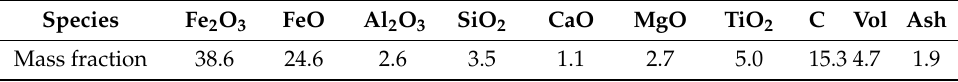
Table 5. Chemical composition of raw